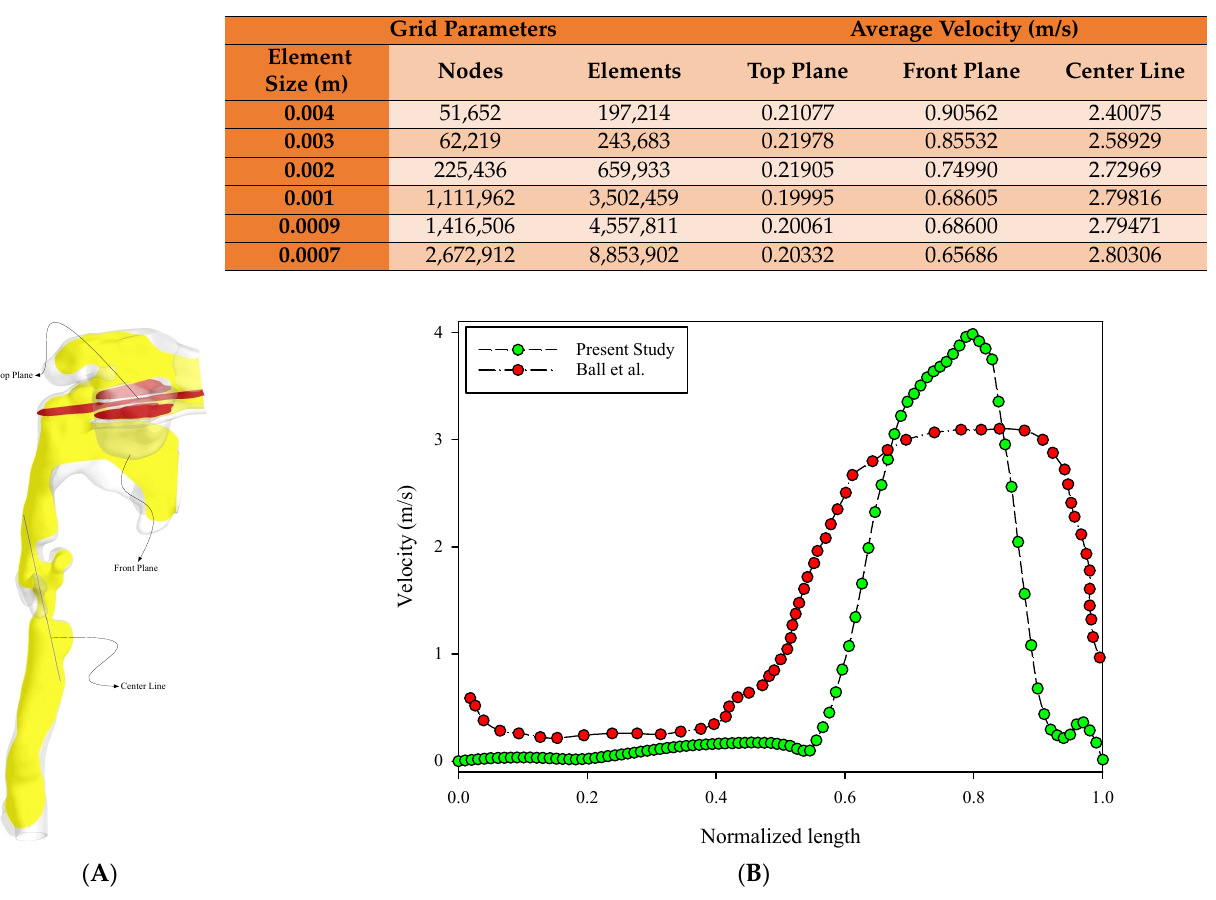
Table 1. Numerical values related to changes in the average velocity value according to mesh size.